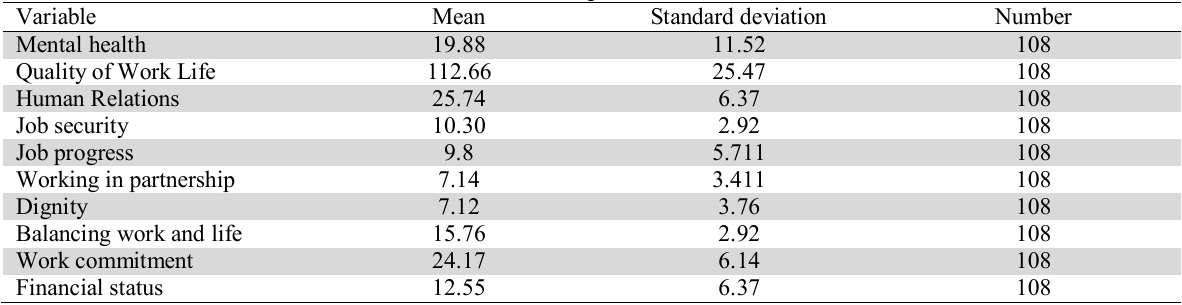
The results of mean and standard deviation of the questionnaire Variable